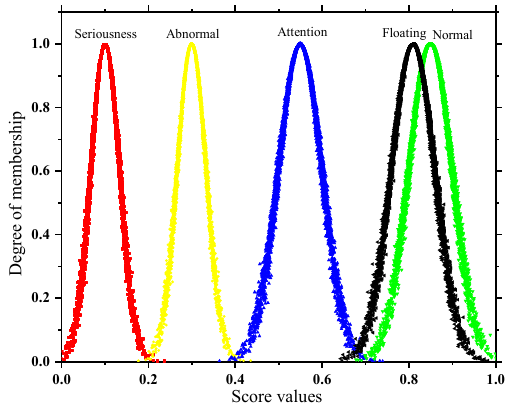
Figure 9. Membership degree of x 32.